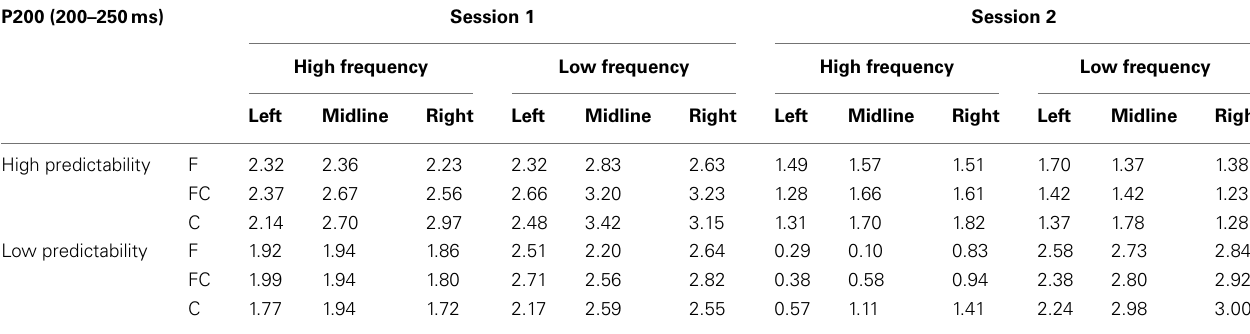
Table 3 | Mean amplitudes of P200 for each condition and each electrode of interest in each session. P200